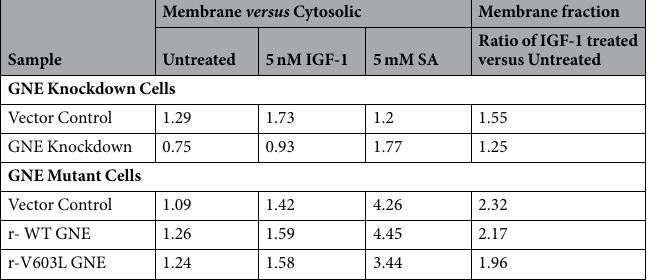
Table 1. Ratio of IGF-1R distribution in various sub-cellular fractions: Ratio of IGF-1R levels in membrane versus cytosolic fraction of various cell lines as calculated by densitometry analysis of Fig. 3 blots. Comparison determines IGF-1R distribution with respect to GNE deficiency. The last column indicate the ratio of IGF-1R distribution in membrane fraction after IGF-1 treatment versus untreated to determine plasma membrane migration pattern.